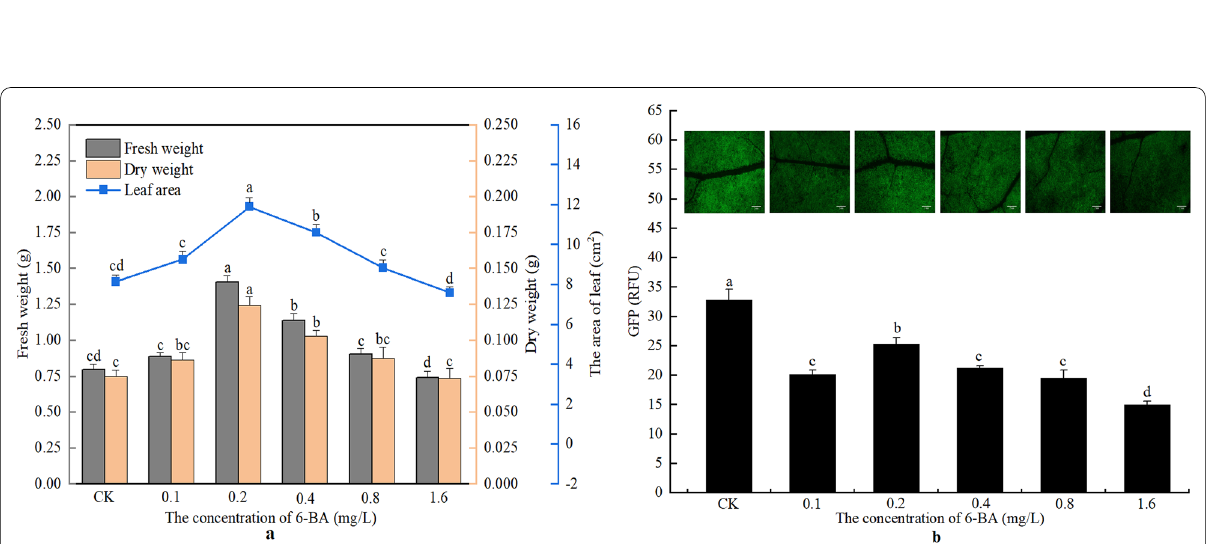
Fig. 3 The changes in biomass and GFP fluorescence intensity of seedlings under different 6‑BA concentrations. a The changes of fresh weight, dry weight, and leaf area of the seedlings after treatment with different concentrations of 6‑BA. b The changes in GFP fluorescence intensity in the leaves of the seedlings treated with different concentrations of 6‑BA. Bar 2 mm. CK, Treatment with water; 6‑BA: 6‑benzyladenine. The values of = RFU (relative fluorescence unit) are average standard error (SE) of three individual replicates. Different lowercase letters indicate that there are ± significant differences in the same parameter among the treatment with different concentrations of 6‑BA at the P < 0.05